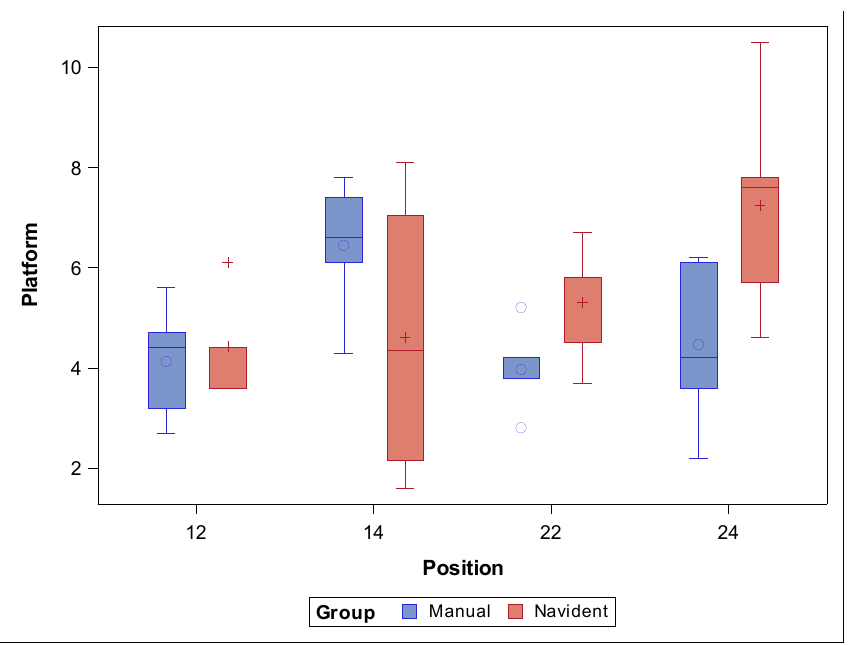
Figure 5. Box plot of deviations at the coronal entry point observed in the study groups and ZI positions. Median values are represented by the horizontal lines within each box. The symbols rep- resent extreme values.